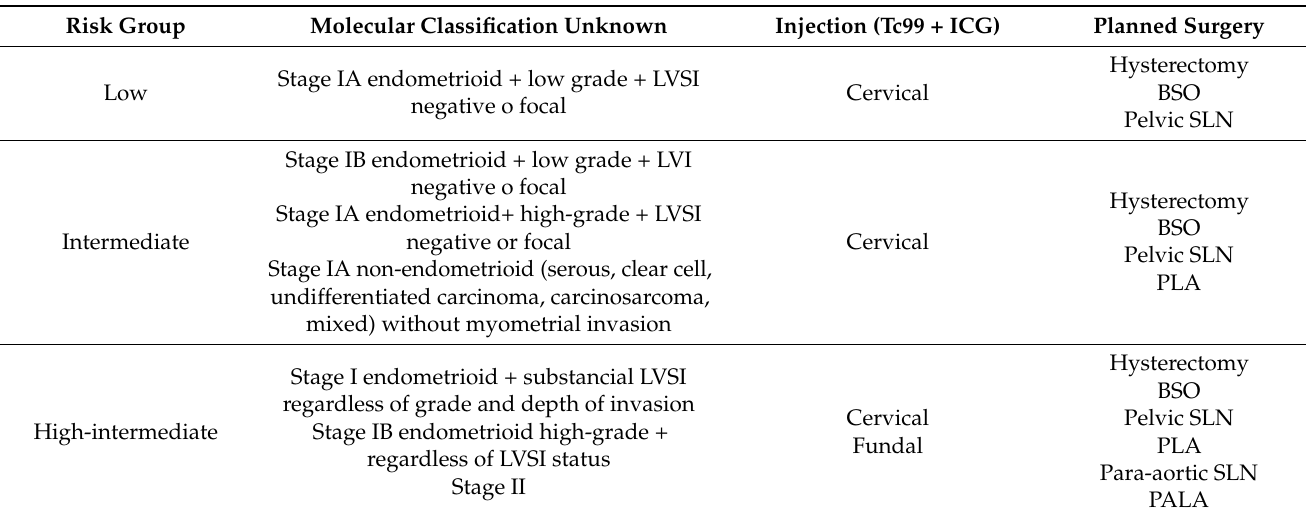
Table 2. Planned surgery according to ESGO/ESTRO/ESP recommendations: LVSI, lymphovascular space invasion; BSO, bilateral salpingo-ooforectomy; SLN, sentinel lymph node dissection; PLA, pelvic lymphadenectomy; PALA, para-aortic